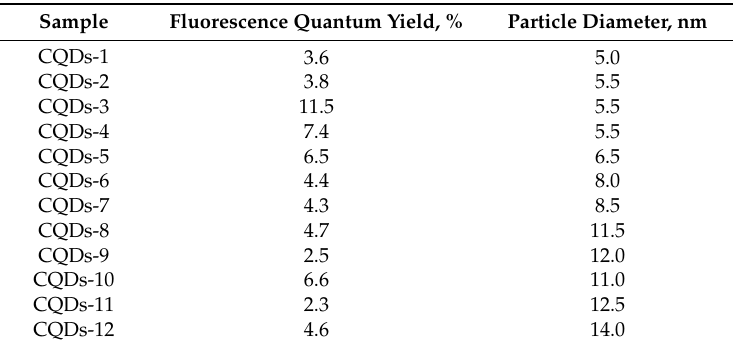
Table 2. Chitosan-based CQDs fluorescence quantum yield